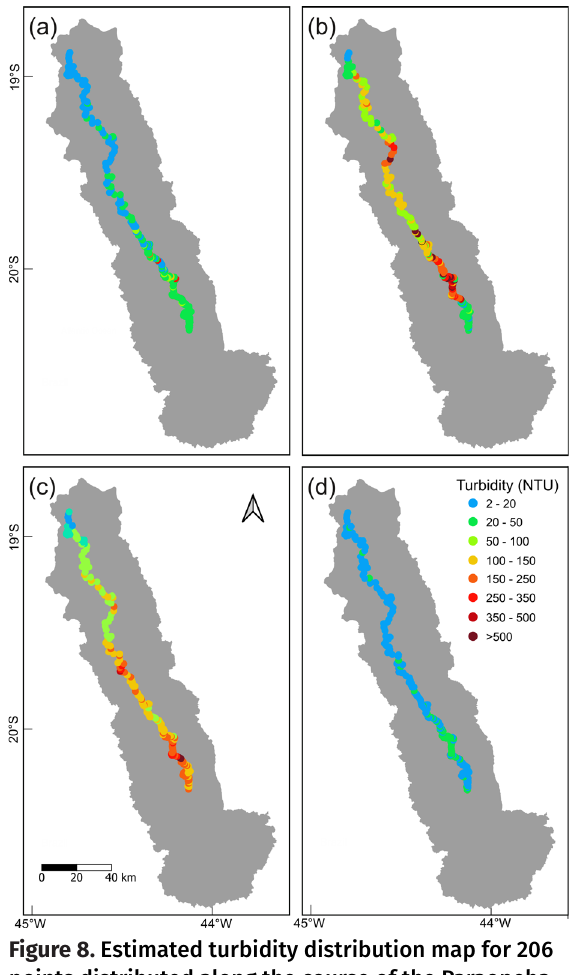
Figure 8. Estimated turbidity distribution map for 206 points distributed along the course of the Paraopeba River: a) January 22, 2019; b) March 8, 2019; c) May 27, 2019; and d) September 19, 2019. The highest turbidity was observed during March 2019, declining in the following months, and reaching lower values in September 2019. This trend strongly matches with the general trend seen in the field measurements, shown in Figure